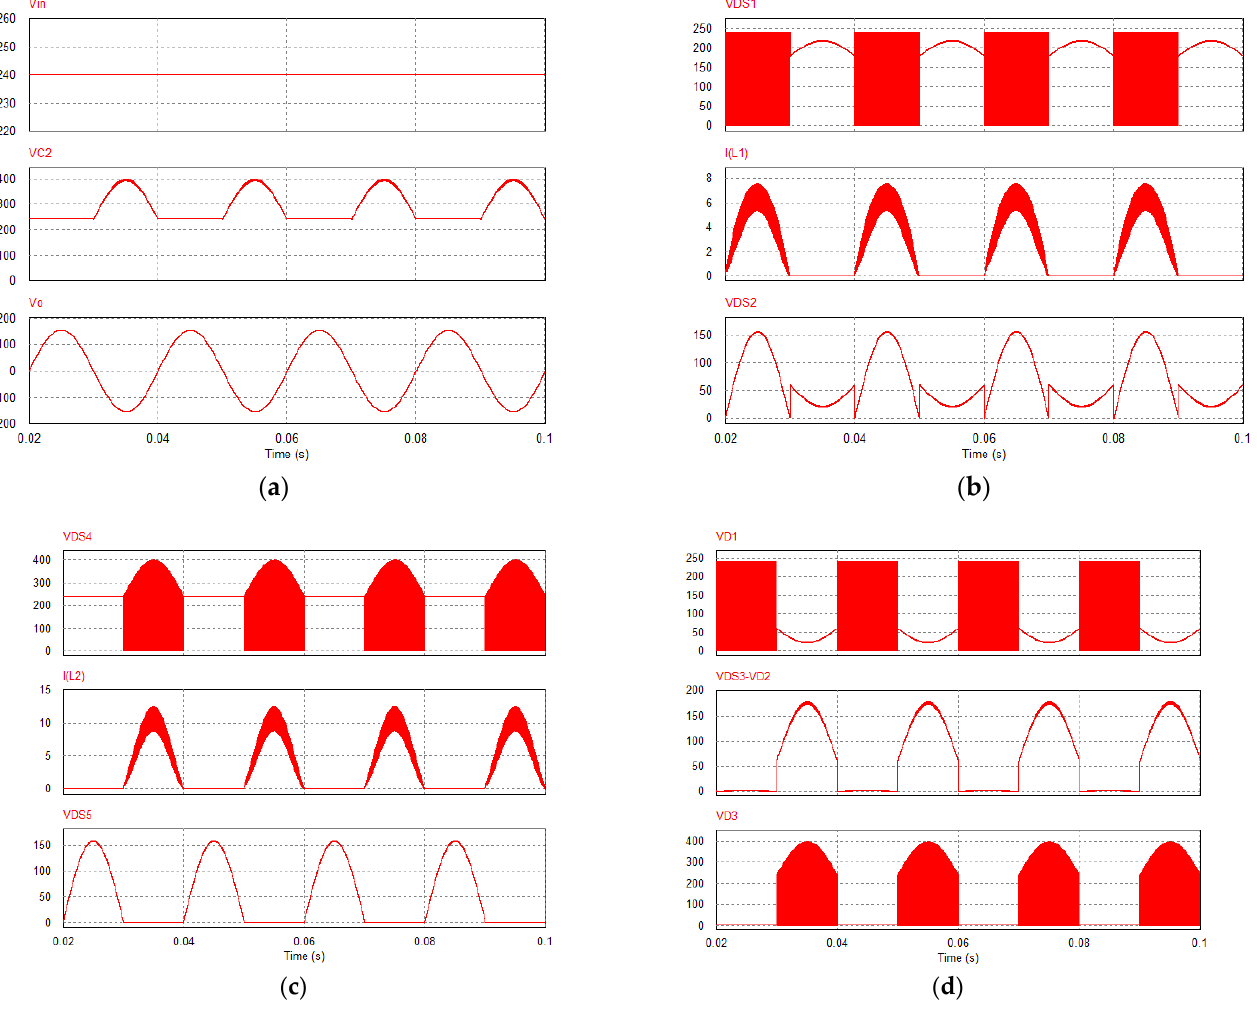
Figure 7. Simulation results with V in = 240 V. ( a ) the input, output and capacitor C 2 voltages, ( b ) the voltage stress on switches S 1 , S 2 , and the current of inductor L 1 , ( c ) the voltage stress on switches S 4 , S 5 , and the current of inductor L 2 , and ( d ) the voltage stress on diodes D 1 , D 2 , D 3 and the voltage stress on switch S 3 . Table 3. The power loss of the proposed CGBBI with simulation.